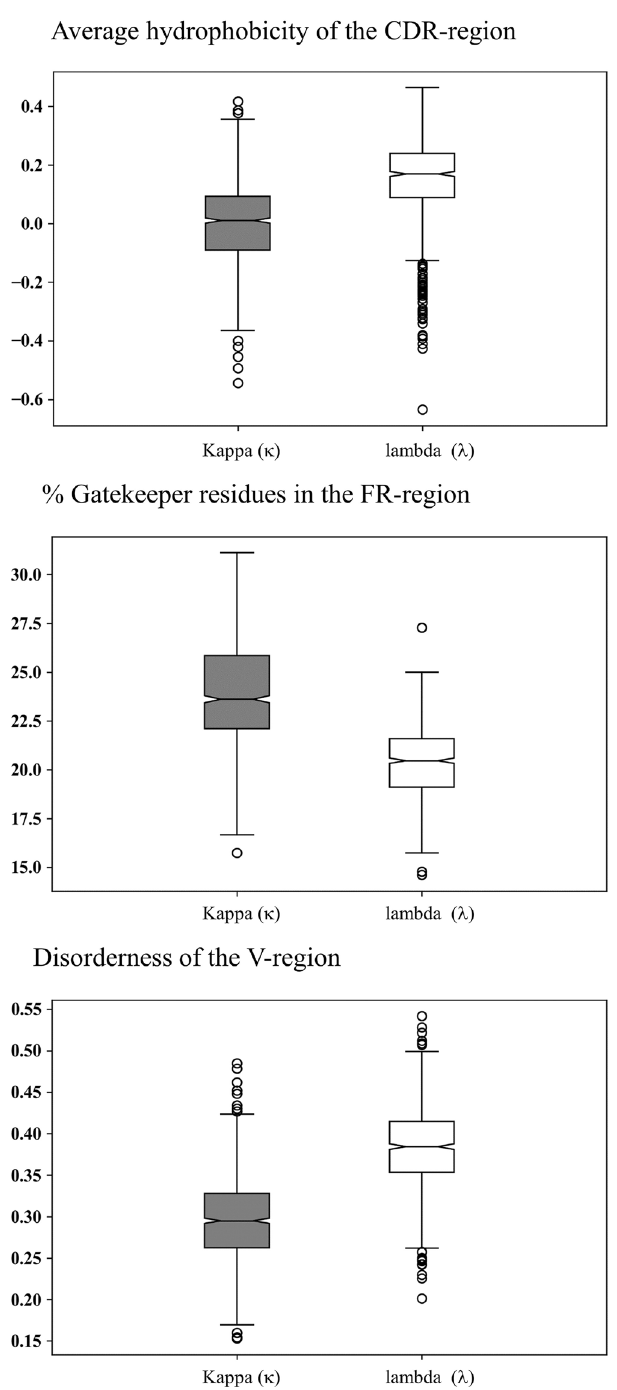
Figure 3. The aggregation-related features ( a ) average hydrophobicity of the CDRs, ( b ) percentage of gatekeeper residues in FRs and ( c ) disorderness score (from IUPred2A server) calculated for kappa (grey) and lambda (white)